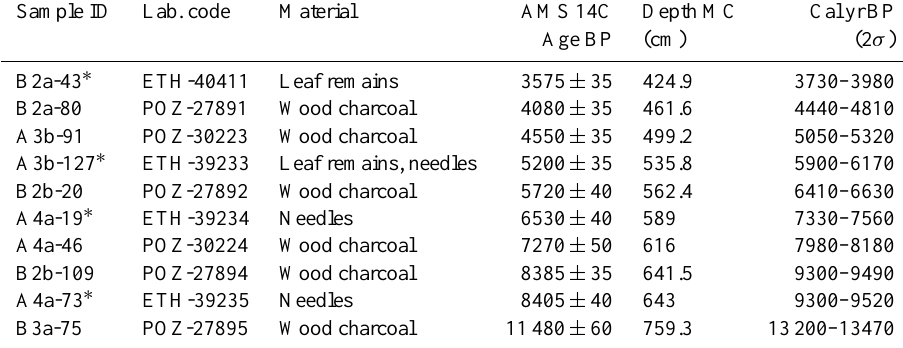
Table 1. AMS radiocarbon dates with a 2 σ age range calibration from the Lake Ledro LL081 core. Sample